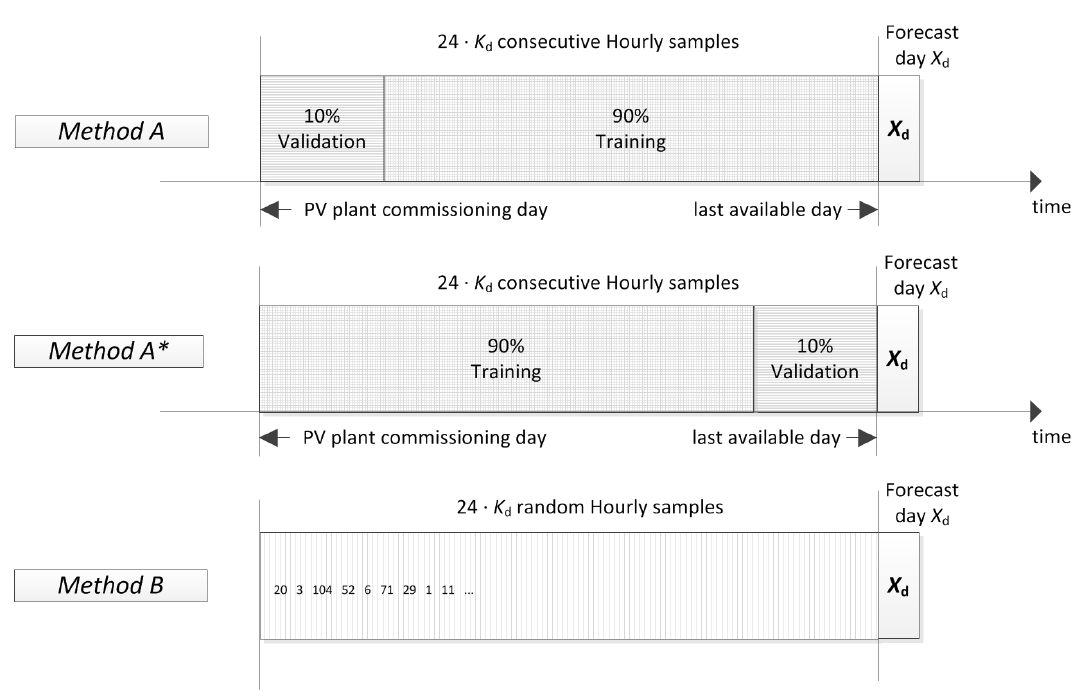
Figure 4. Training database composition for methods A, A*, and B.